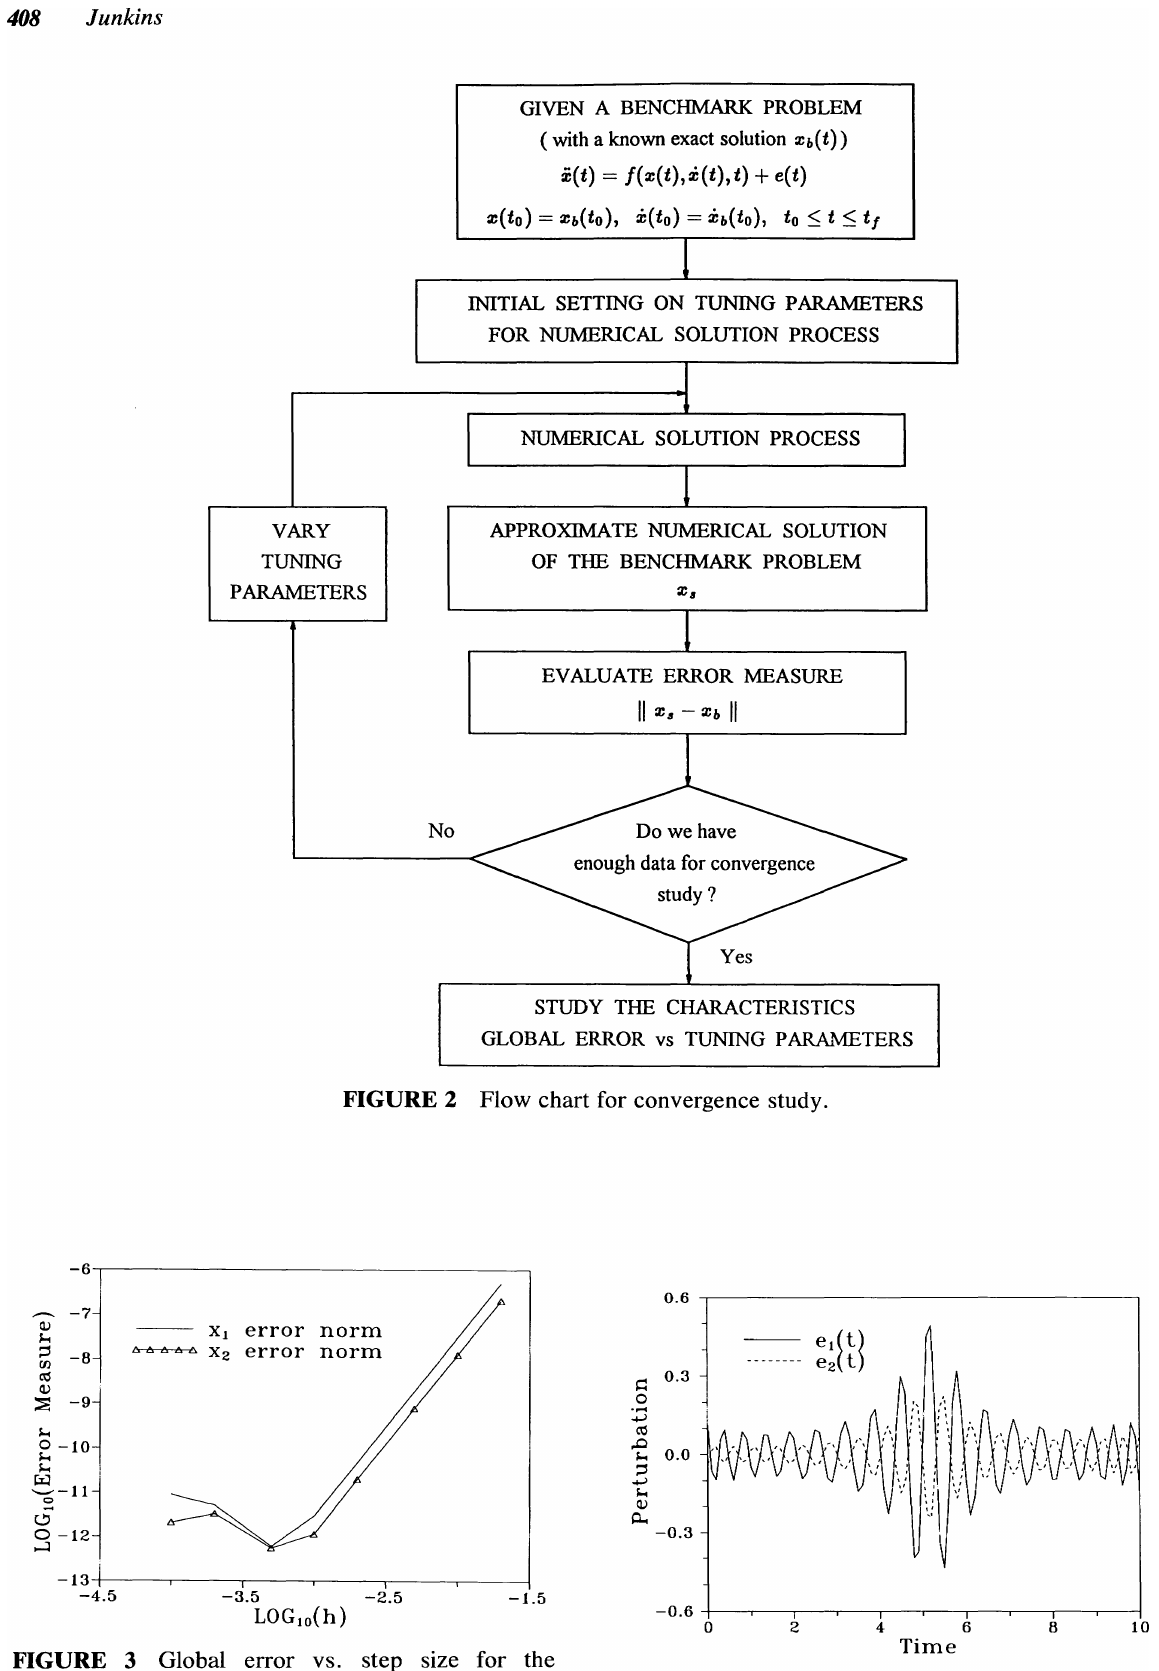
FIGURE 3 Global error vs. step size for the benchmark problem. FIGURE 4 Perturbation terms of example